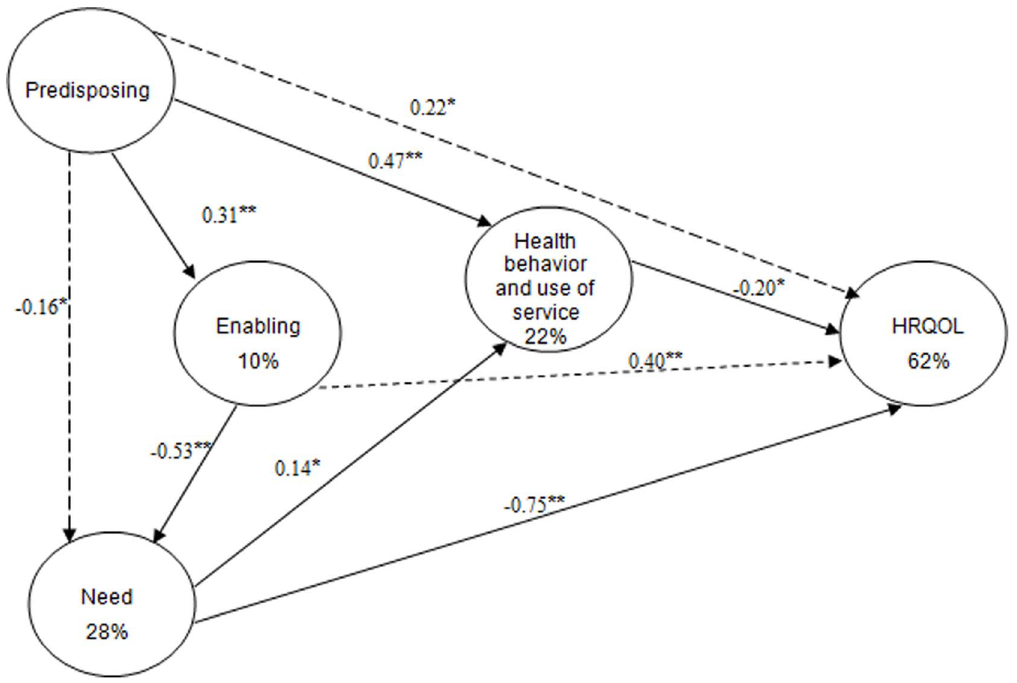
Figure 3. Structural model for Andersen’s behavioral model. Standardized path coefficients are shown. * P , 0.05; ** P , 0.01. GFI=0.967; CFI=0.886; TLI=0.855; SRMR=0.047; RMSEA=0.047. Chi-Square/DF=2.916. Solid lines=direct effect; dashed lines=indirect effect.